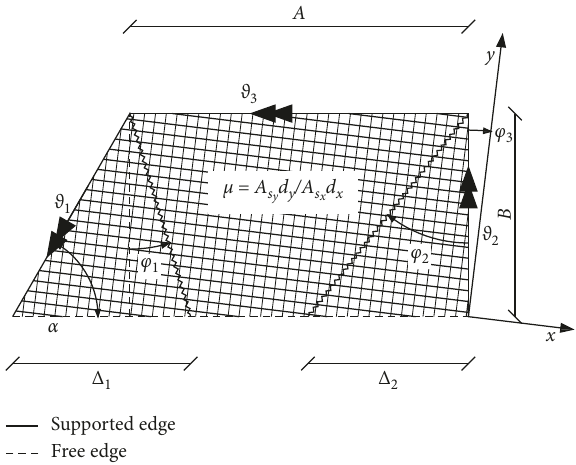
Figure 8: Trapezoidal R/C slab with reinforcement grid at an angle to the free edge. The angle between direction y of the weaker re- inforcement and the direction at a right angle to the free edge is φ 3 , assumed as an additional parameter in the optimization